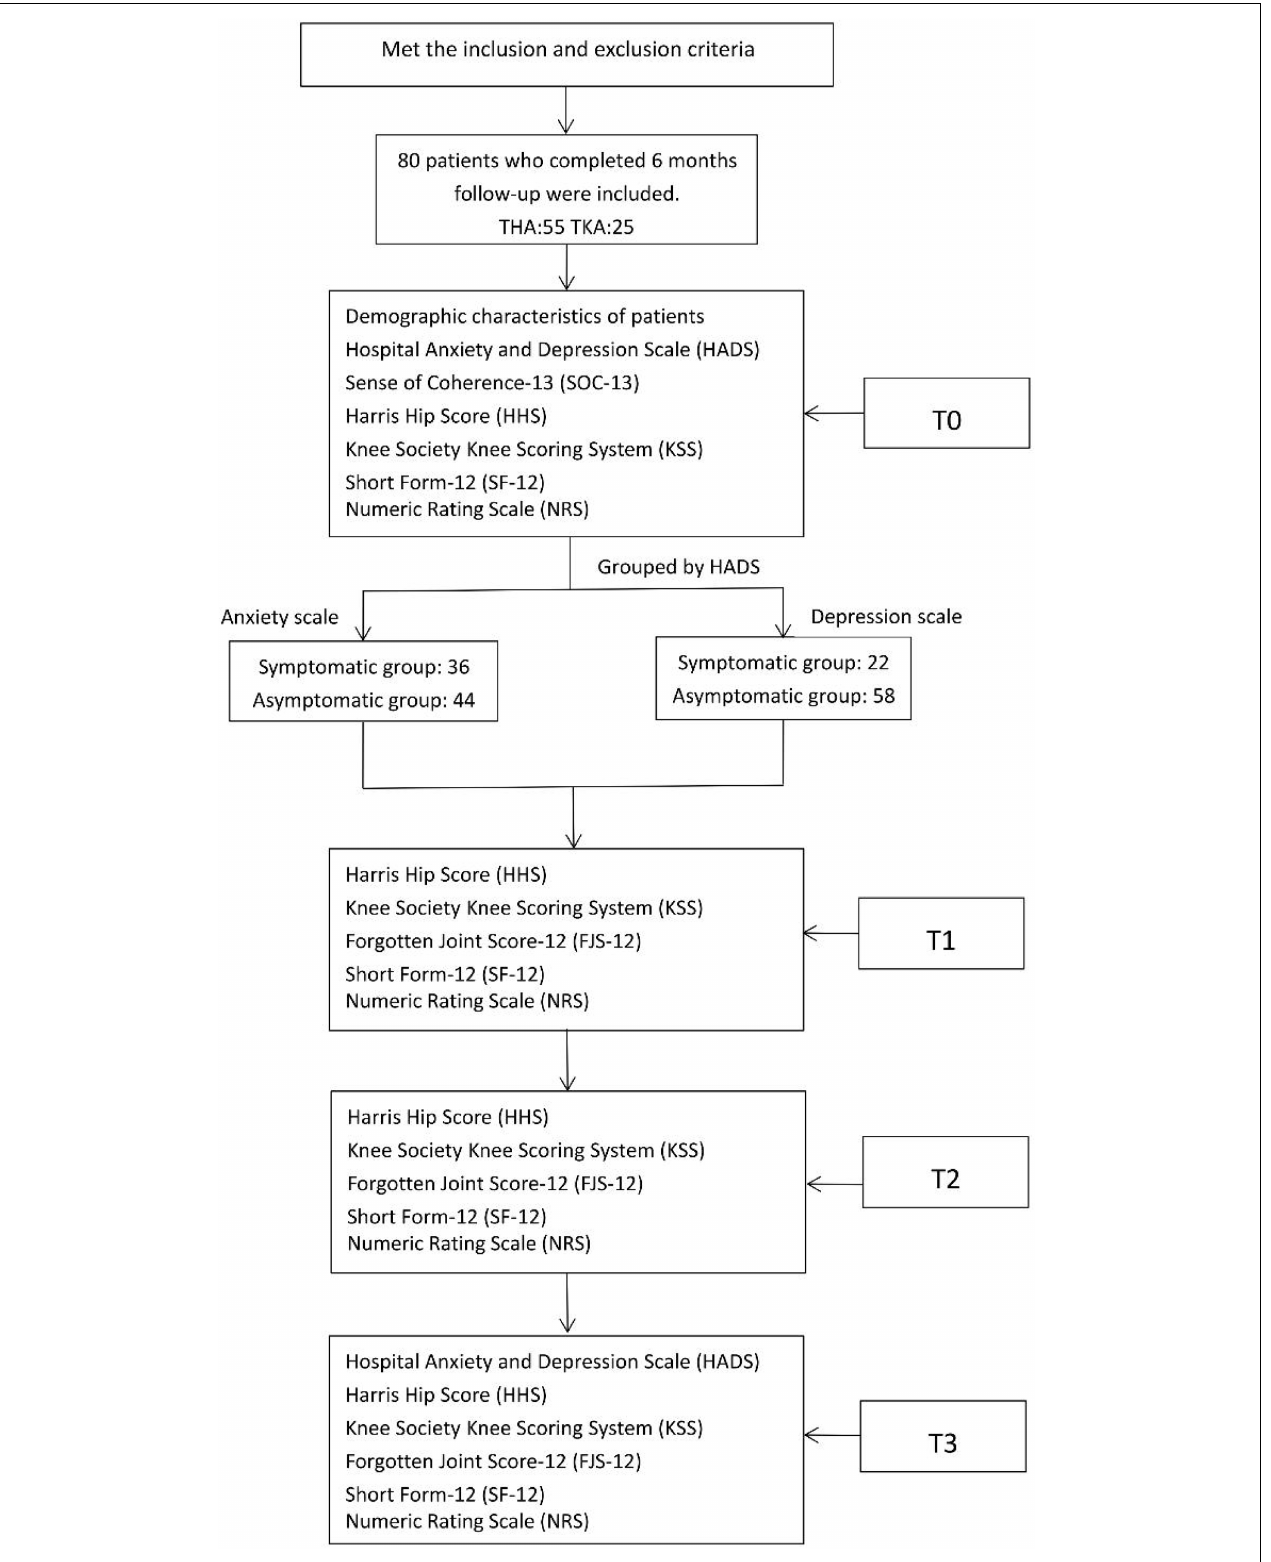
FIGURE 1 | Flowchart for the study